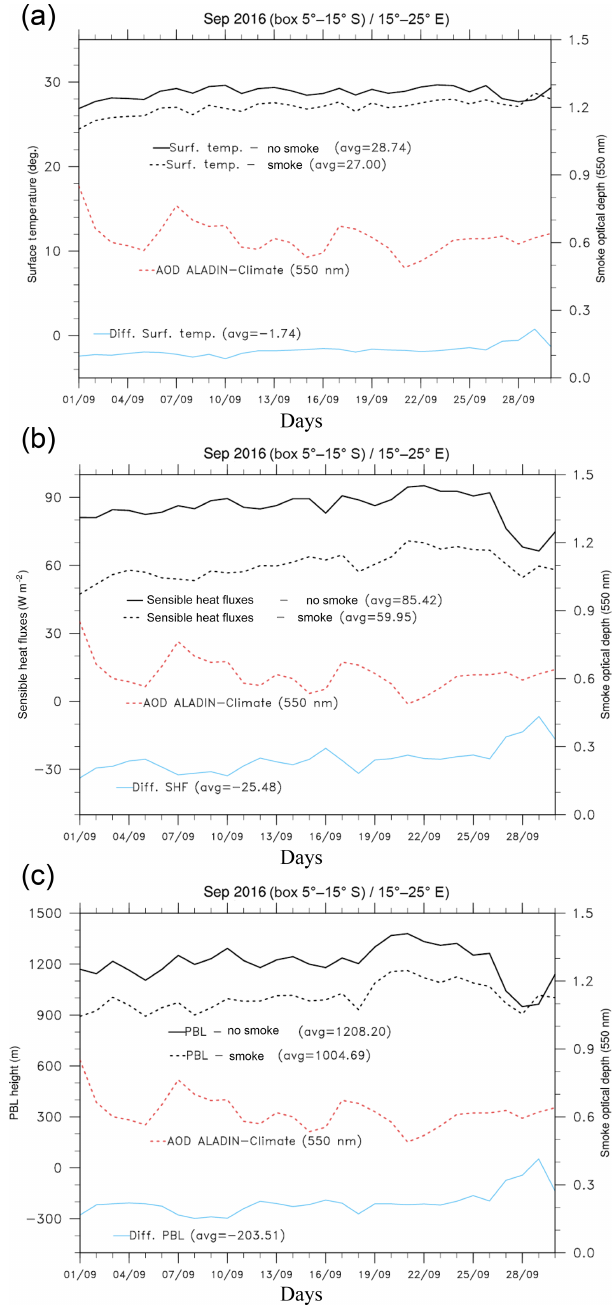
Figure 15. Daily mean surface temperature, sensible heat fluxes and PBL height obtained from the CTL (black lines) and SMK (dashed black lines) ALADIN-Climate simulations for September 2016. The AOD (dashed red lines) and the difference between the two simulations (CTL and SMK) for each variable are also reported (blue